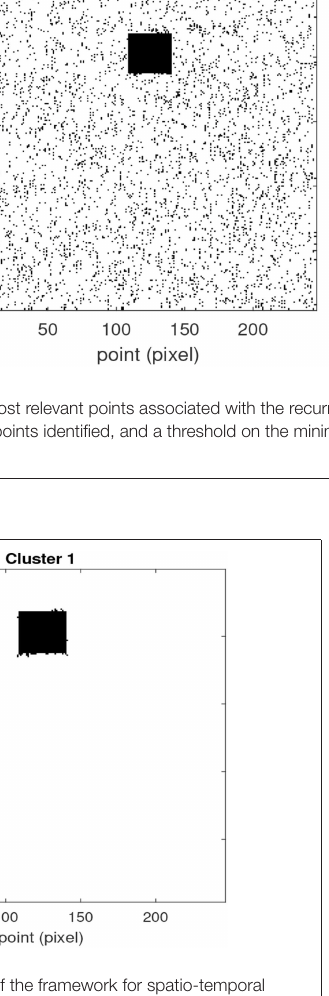
FIGURE 5 | Example of application of the framework for spatio-temporal detection of recurrence introduced in section 3.1 to the example of Figure 2 . Shown is a summary of the analysis as outputted by our software. In black the detected recurrence area is indicated. The estimated time interval (frame range) of the recurrent pattern is also